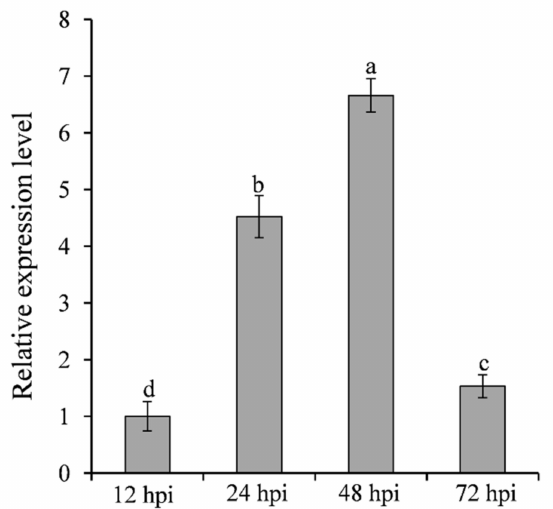
Figure 2. Analysis of SNTF2 transcription at different infection phases by qRT-PCR. The cDNA was obtained from the apple leaves at 12, 24, 48, and 72 h post-inoculation (hpi) with Colletotrichum gloeosporioides . The M. domestica ubiquitin extension factor ( MdUBQ ) gene was used as the reference gene to normalize and analysis the transcription of SNTF2 . Results were presented as the average fold values from three independent experiments compared with 12 hpi samples. Error bars represent standard deviations. Lowercase letters indicate significant differences ( p <